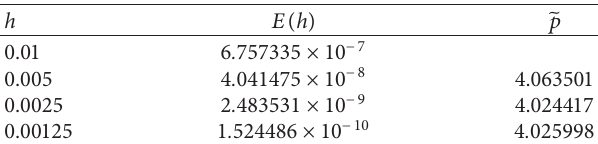
Table 3: The maximum global errors E ( h ) and the observing orders 􏽥 p produced by MS4 when applied to equation